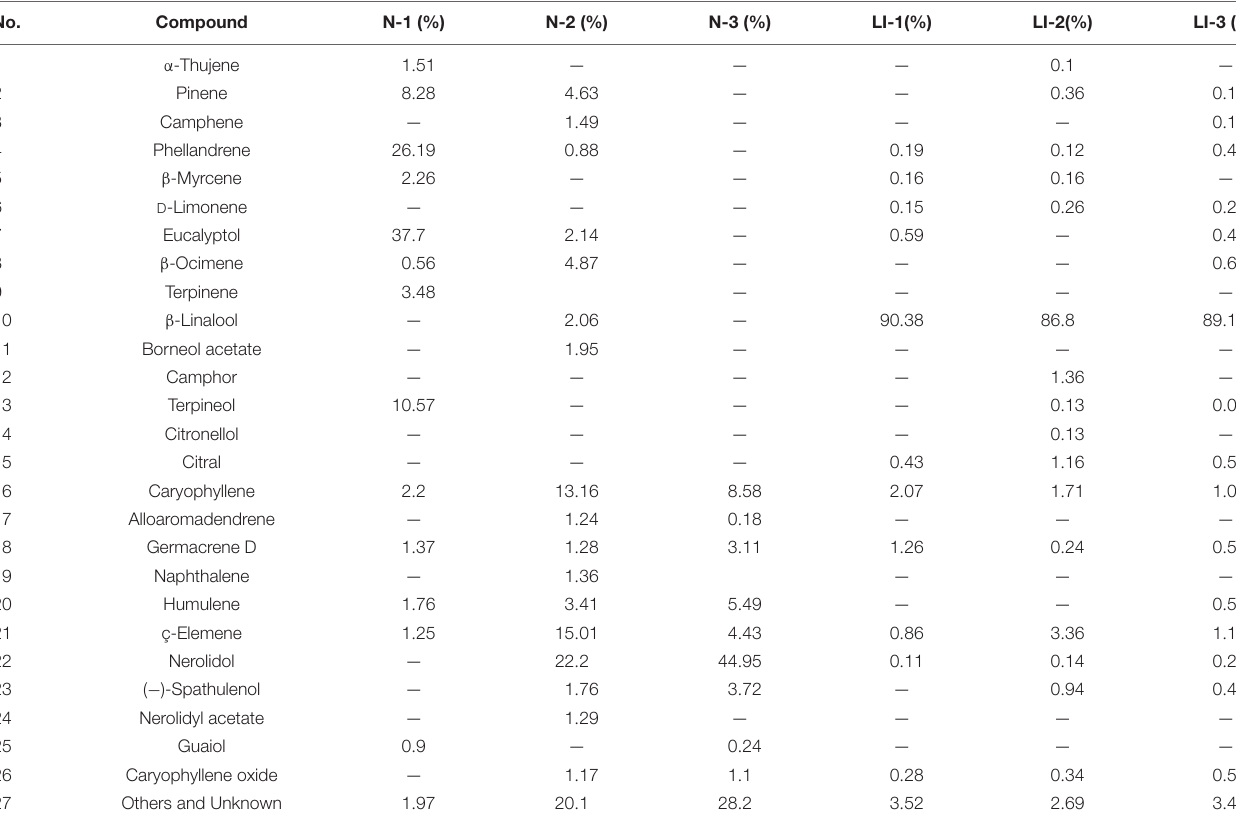
TABLE 1 | Chemical composition of the essential oils from leaf extracts of C. camphora .